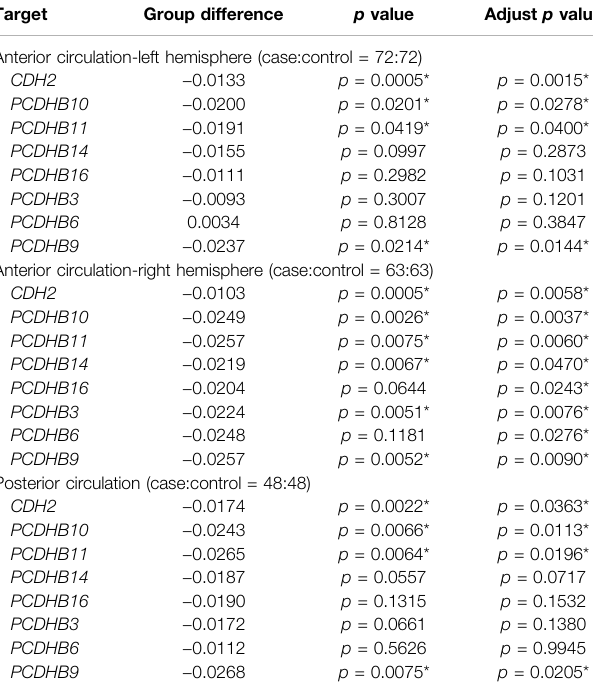
TABLE 4 | Strati fi ed analysis by gender. Target